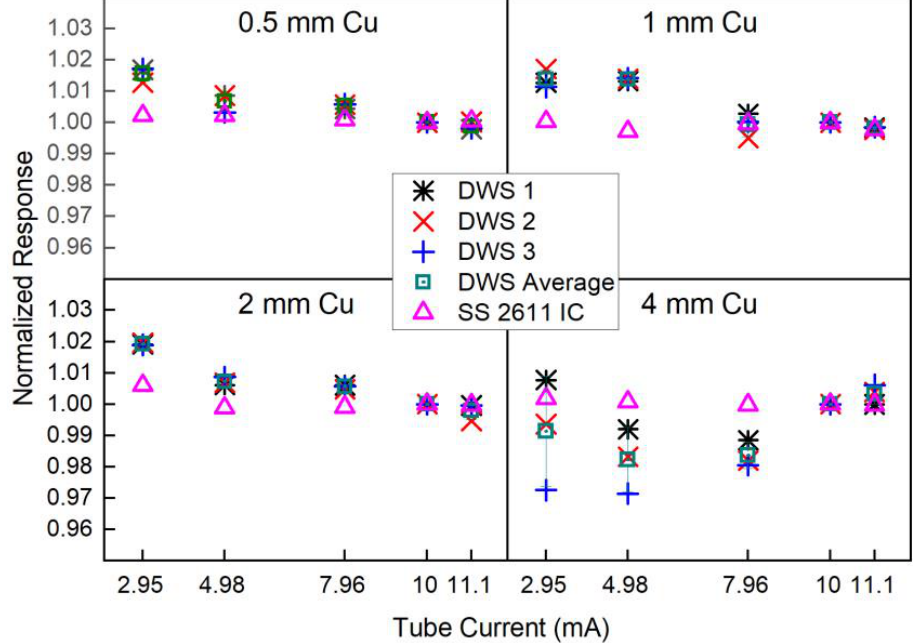
Figure 3. Normalized scintillators’ response to dose rate variation (expressed by changes in the tube current) for different HVLs (0.5, 1, 2 and 4 mm Cu). Errors bars represent the standard deviation of the mean (no visible if smaller than the data point marker).